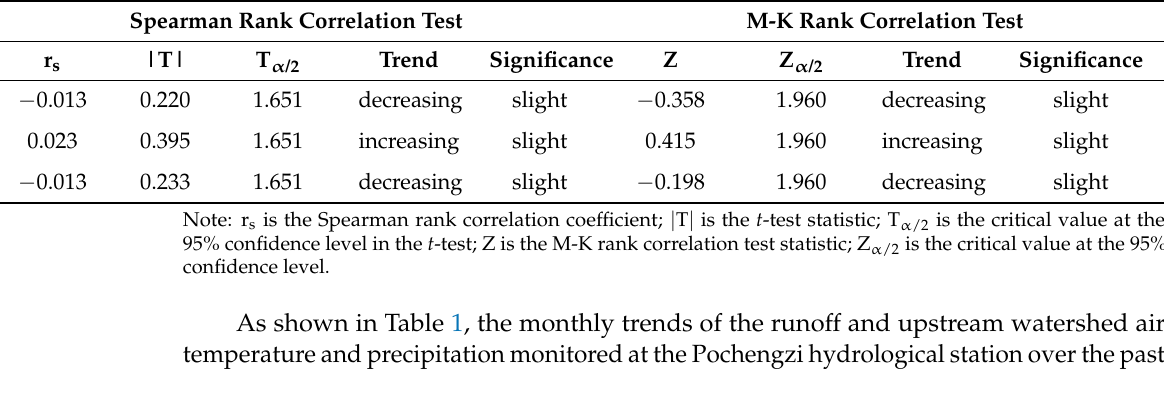
Table 1. Average monthly trends of the runoff, air temperature, and precipitation from 1990 to 2015 at Pochengzi hydrological station and its upstream